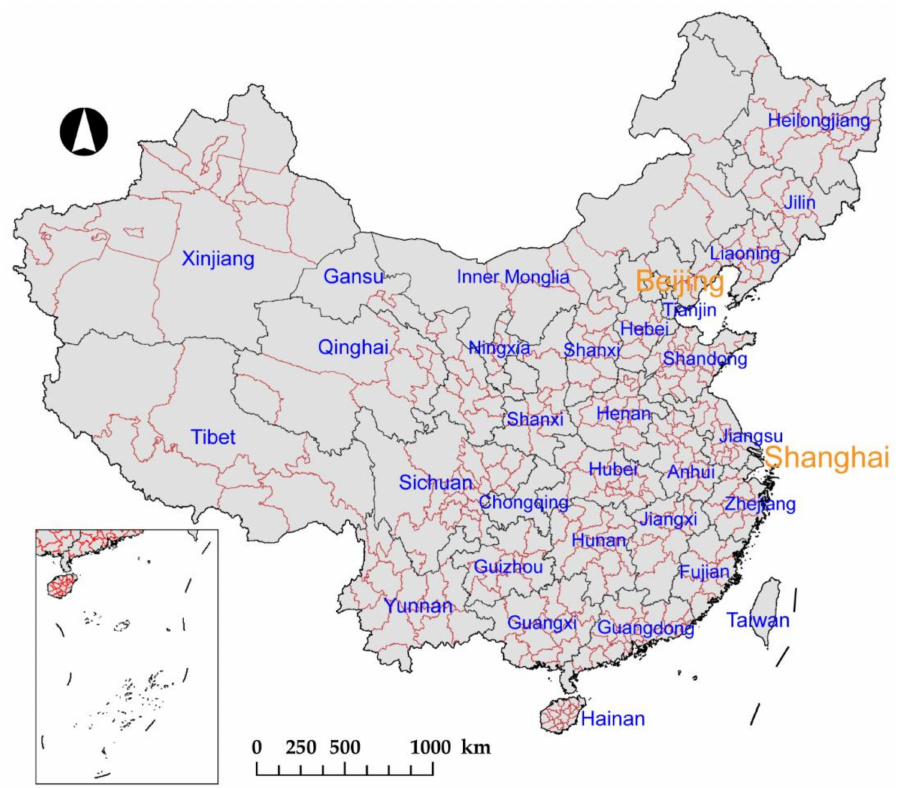
Figure 1. The administrative levels of China. Note: red and black lines are provincial and prefectural boundaries,